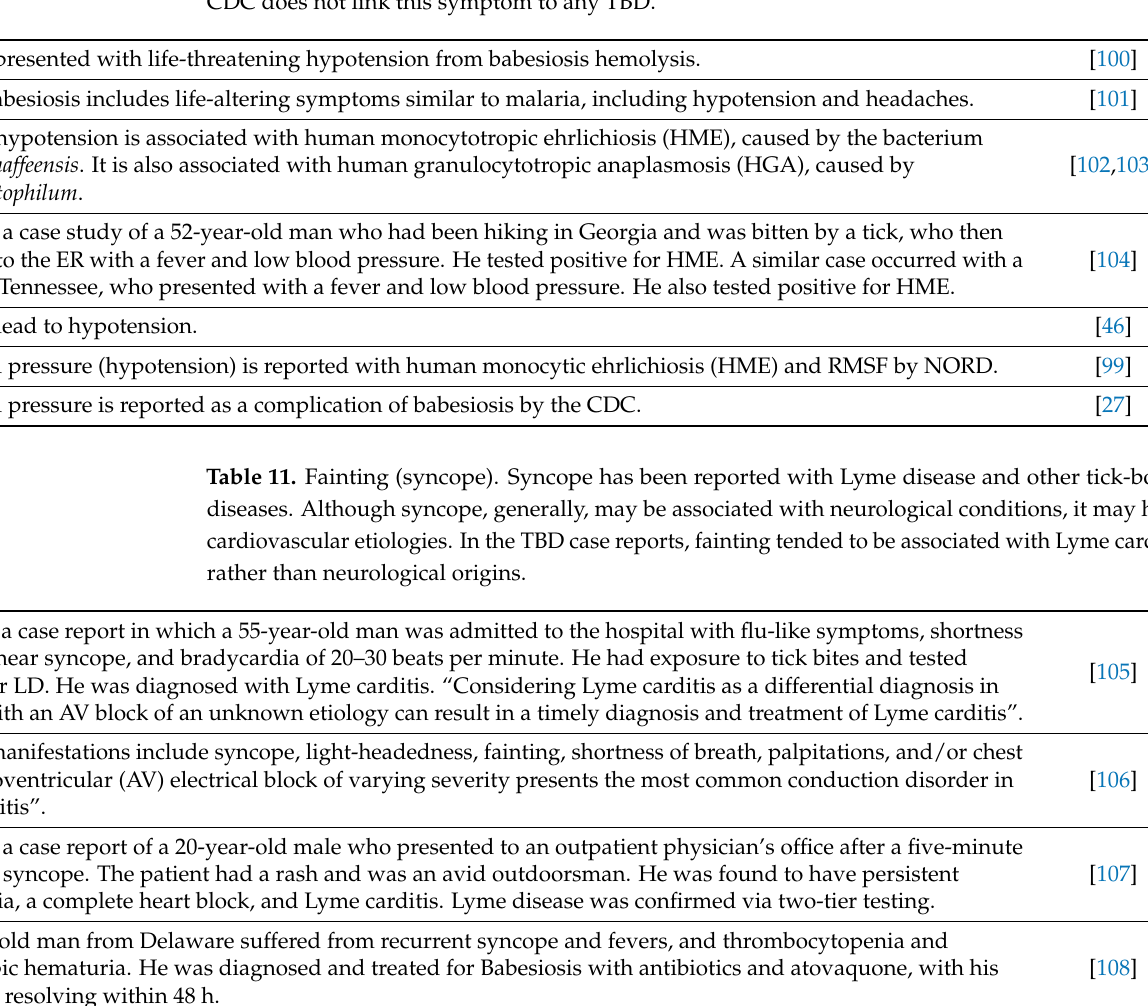
Table 10. Low blood pressure (hypotension). Hypotension is associated with autonomic nervous system dysfunction and is demonstrated primarily with ehrlichiosis in the case reports. The National Organization for Rare Diseases (NORD) recognizes hypotension with ehrlichiosis and RMSF, but the CDC does not link this symptom to any TBD.